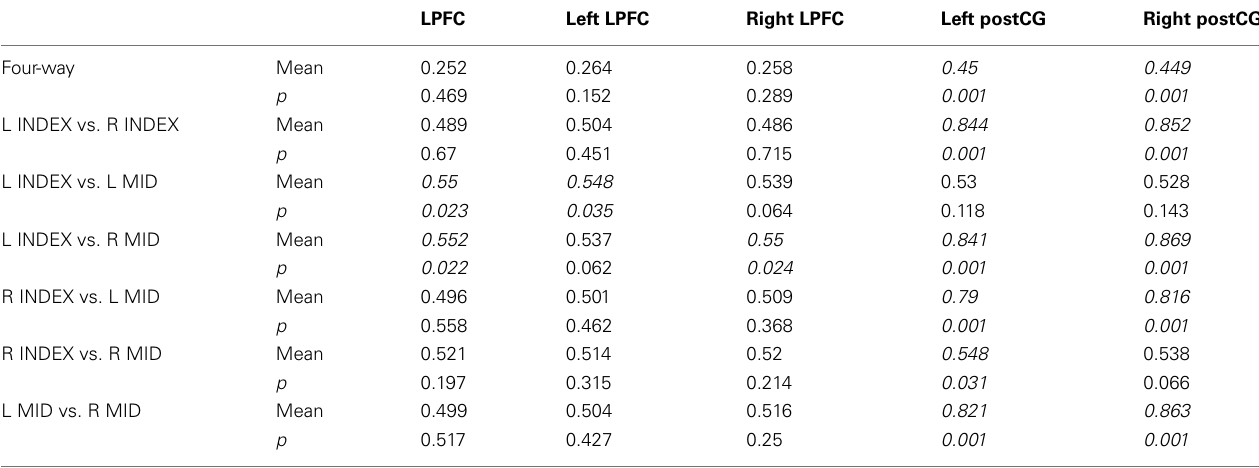
Table 2 | Response rule classification test results.